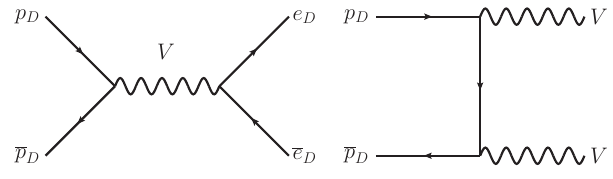
Figure 2: Dark matter annihilation processes. Due to the light mediator the anni- hilations are Sommerfeld enhanced. Unstable p radiatively and decay into mediators, thus depleting the DM